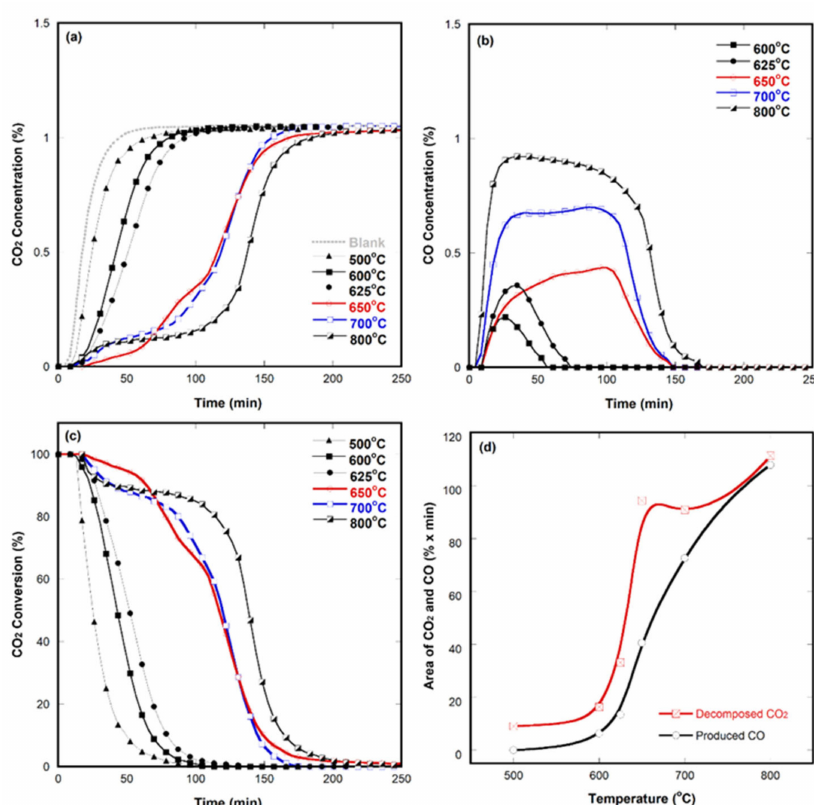
Figure 3. Isothermal CO 2 decomposition results obtained using SrFeO 3 − δ at various temperatures: ( a ) Decomposed CO 2 concentration, ( b ) produced CO concentration, ( c ) CO 2 conversion as a function of time, and ( d ) decomposed CO 2 and produced CO area extracted from ( a ) and ( b